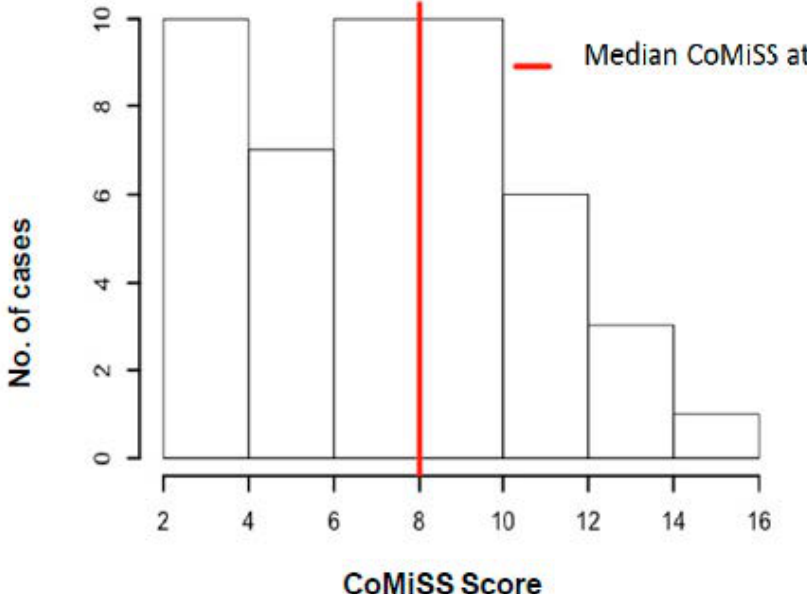
Figure 1. Distribution of the cow’s milk-related symptom score (CoMiSS TM ) in symptomatic infants. T0: Time 0 (first visit).